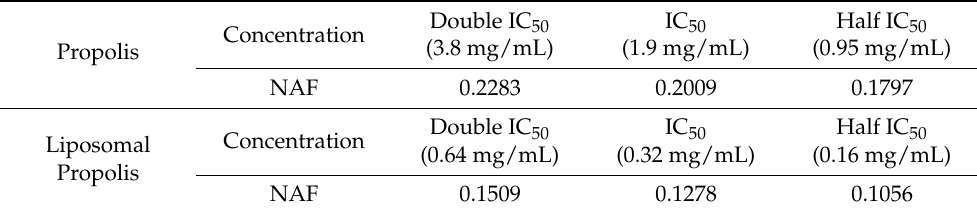
Table 6. The mean value of NAF of Hep-2 cells treated with increasing concentrations of propolis (half IC 50 , IC 50, and double IC 50 ) and liposomal propolis (half IC 50 , IC 50, and double IC 50 ); the mean value of NAF of control Hep-2 cells was 0.3243.